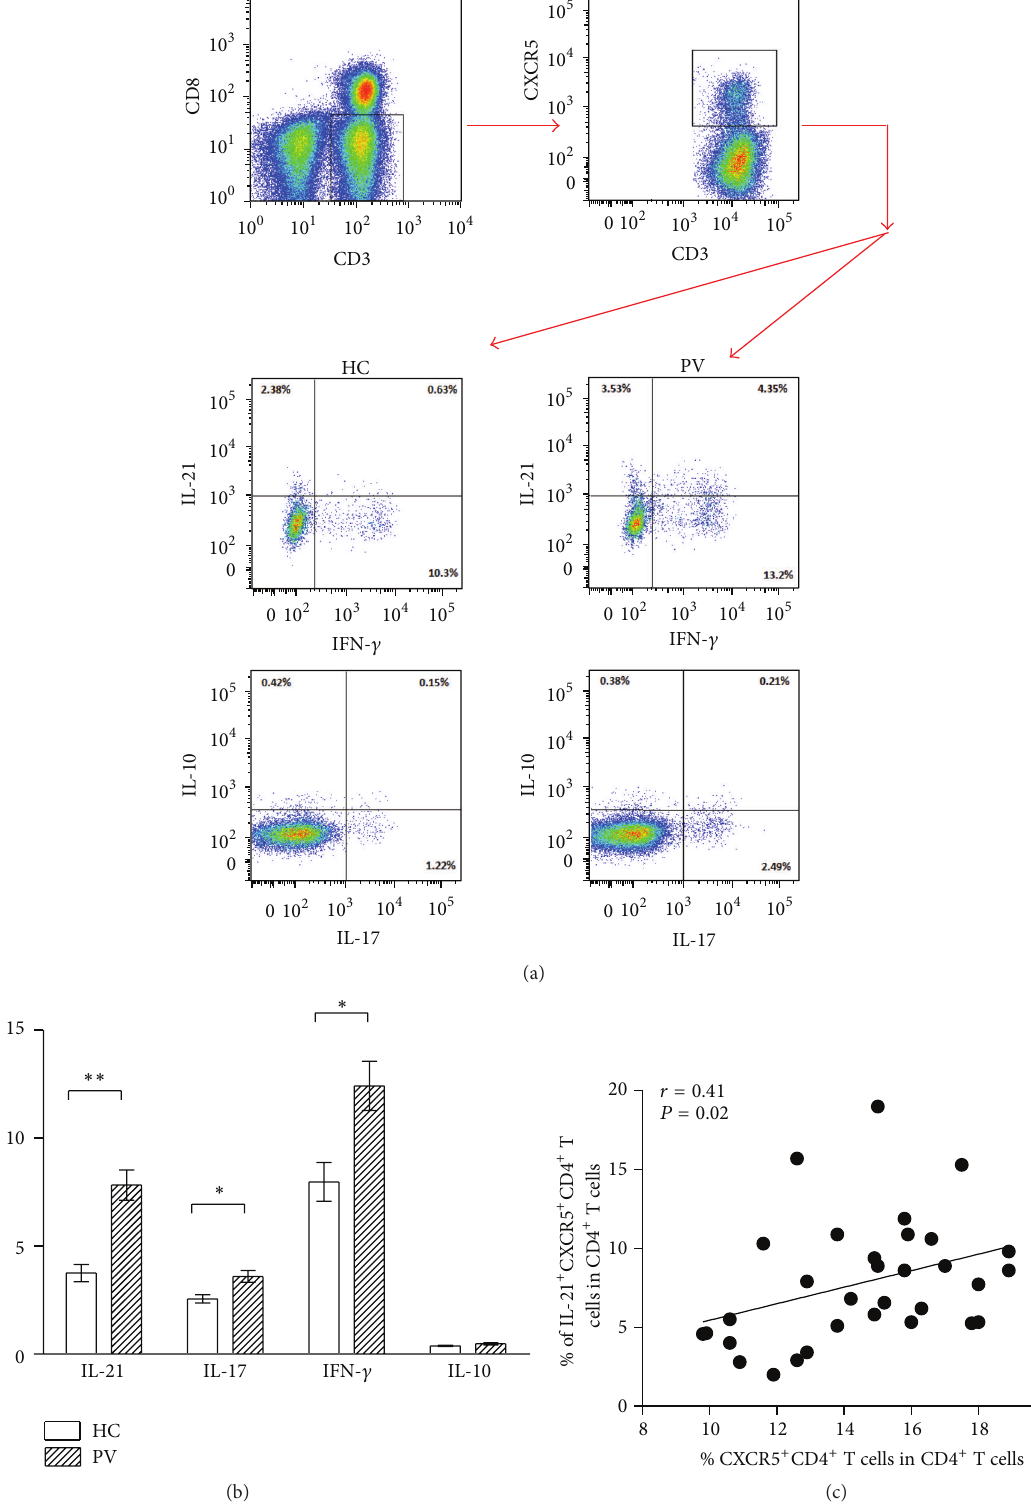
Figure 3: Cytokine production by cTfh cells in patients with psoriasis vulgaris and healthy controls. (a) Represent profiles of IL-21, IFN- 𝛾 , IL-17, and IL-10 secreted by cTfh cells in psoriasis patients and healthy controls. (b) cTfh cells produce more IL-21, IFN- 𝛾 , and IL-17 in psoriasis patients than in healthy controls, whereas the secretion of IL-10 shows no significant difference between two groups. ∗ 𝑃 < 0.05 ; ∗∗ 𝑃 < 0.01 . (c) The higher expression of IL-21 on cTfh cells is positively correlated with the frequency of cTfh cells in patients with psoriasis vulgaris ( 𝑃 < 0.05